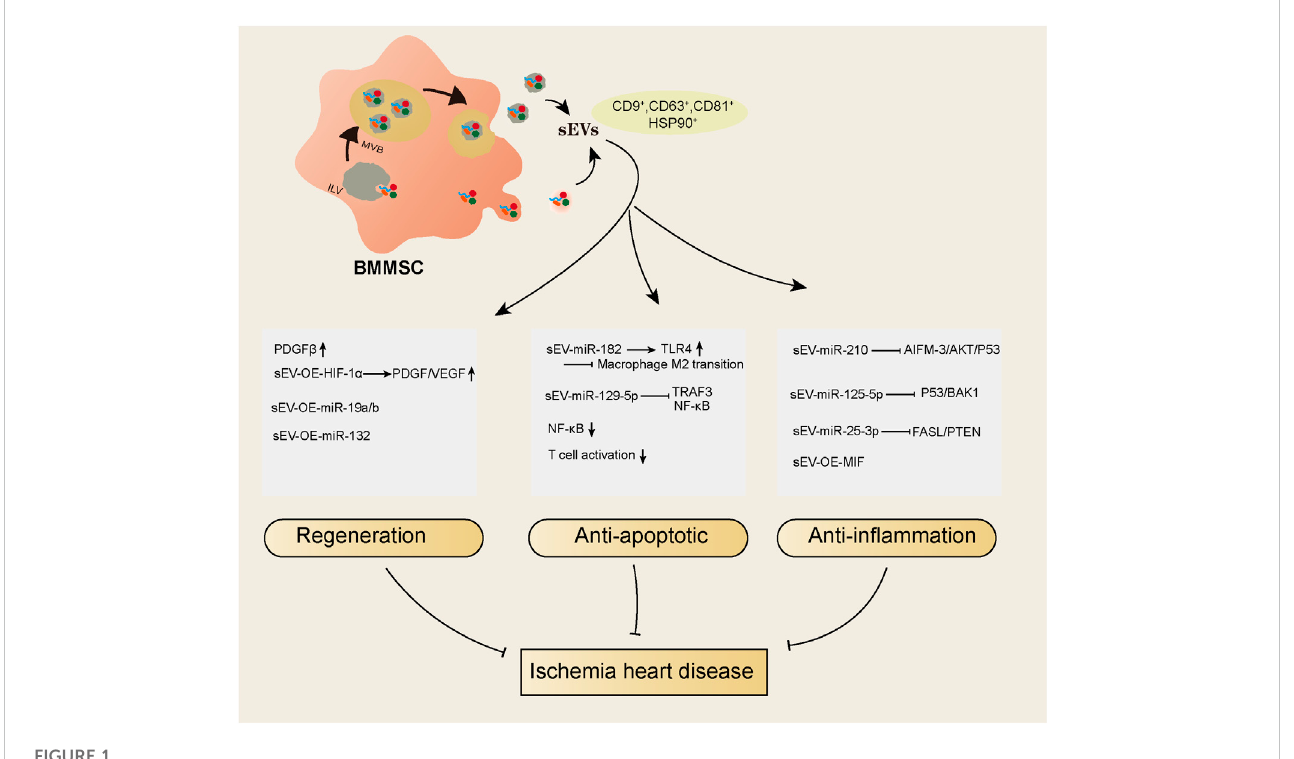
An overall summary of the IHD protective effects of sEVs derived from